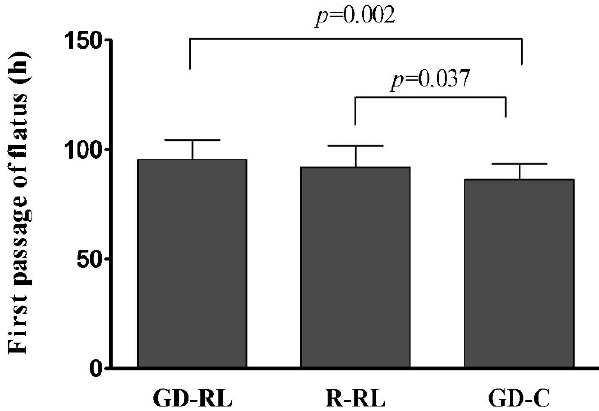
Figure 2 - Time to first passage of